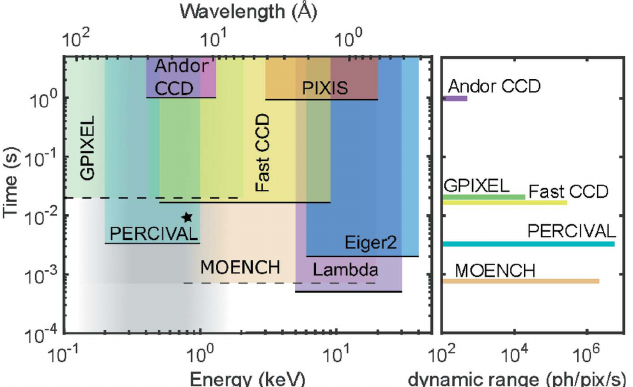
Figure 6 Timescales versus photon energy and/or photon wavelength in the soft and hard X-ray domains. The accessible range for common XPCS detectors are marked. The combination of the PERCIVAL sensor postprocessing (and thus its high sensitivity of low energy photons), together with its high frame rate (up to 300 Hz), will allow the scientific community to access a virtually unknown timescale. The star marks a typical timescale of skyrmion diffusion (size 1 m m) at room temperature (Za´zvorka et al. , 2019). The dynamic range is also compared for the detector systems analyzed at the photon energy E ph = 700 eV.